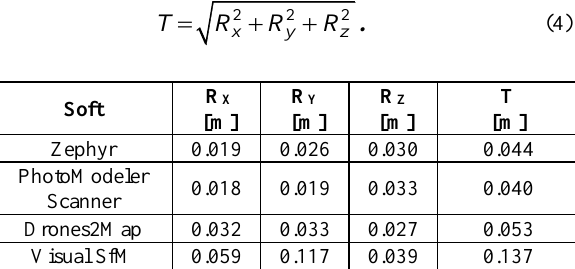
Figure 9. The roof surface modelled in 3D (blue colour) using the GNSS points (a) , Zephyr point cloud (b), Visual SfM point cloud (c) and the best fitting hyperbolic paraboloid shape (yellow colour) from the east side axis (Rx), the RMS along the Y axis (Ry) and the RMS along The parameters a and b of the hyperbolic paraboloid resulting the Z axis (Rz). from the adjustment process of the automatically generated point cloud using different software, are listed in Table 6.